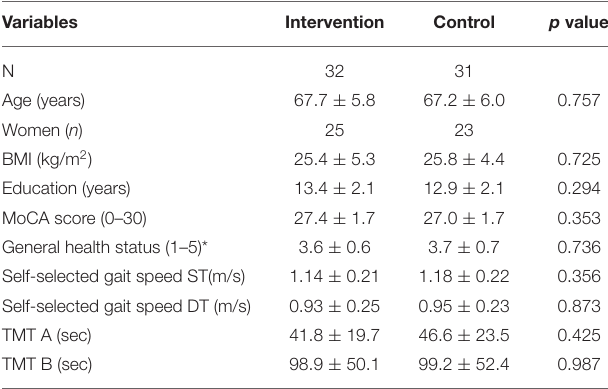
TABLE 1 | Table of baseline characteristics for intervention and control group (intention to treat).